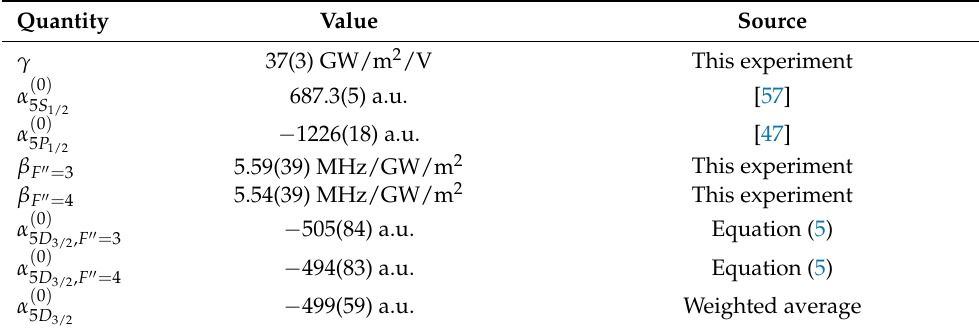
Figure 2. (Color online) Transmission of the 795 nm beam, T 795 , as a function of detuning, δ , without (black solid line) and with (blue solid line) OL for calibration of I 1064 using Equation (3). In all cases, the sample is prepared in identical ways with the lattice on during atom collection (depth (cid:48) = 2 and 3) are resolved, as denoted ∼ h × 15 MHz; see Figure 1c). Both HF states of the 5 P 1/2 level ( F in the Figure. Dashed vertical lines mark the 795-nm transmission minima without OL (black dashed lines at δ = 0 and − 362 MHz) and in the presence of the OL (blue dashed lines). The (not very pronounced) minima of the signals with OL that coincide with the black dashed lines at δ = 0 and − 362 MHz are due to atoms that are not in the OL; these atoms have no ac shifts. The broader signal minima, marked by the blue pair of dashed lines, correspond to atoms trapped near the intensity maxima of the OL; these atoms experience ac shifts due to the OL field. Analyzing the data in this figure, one finds ∆ ν D 1 = 56 ( 4 ) MHz, P T ,1064 = 152 ( 9 ) mV for F (cid:48) = 2 and ∆ ν D 1 = 51 ( 6 ) MHz, P T ,1064 = 160 ( 6 ) mV for F (cid:48) = 3. Table 1. Summary of quantities used in the data analysis and the final results. Although polarizabili- ties are in SI units in most equations in the text, the polarizability values reported in this table are in atomic units for